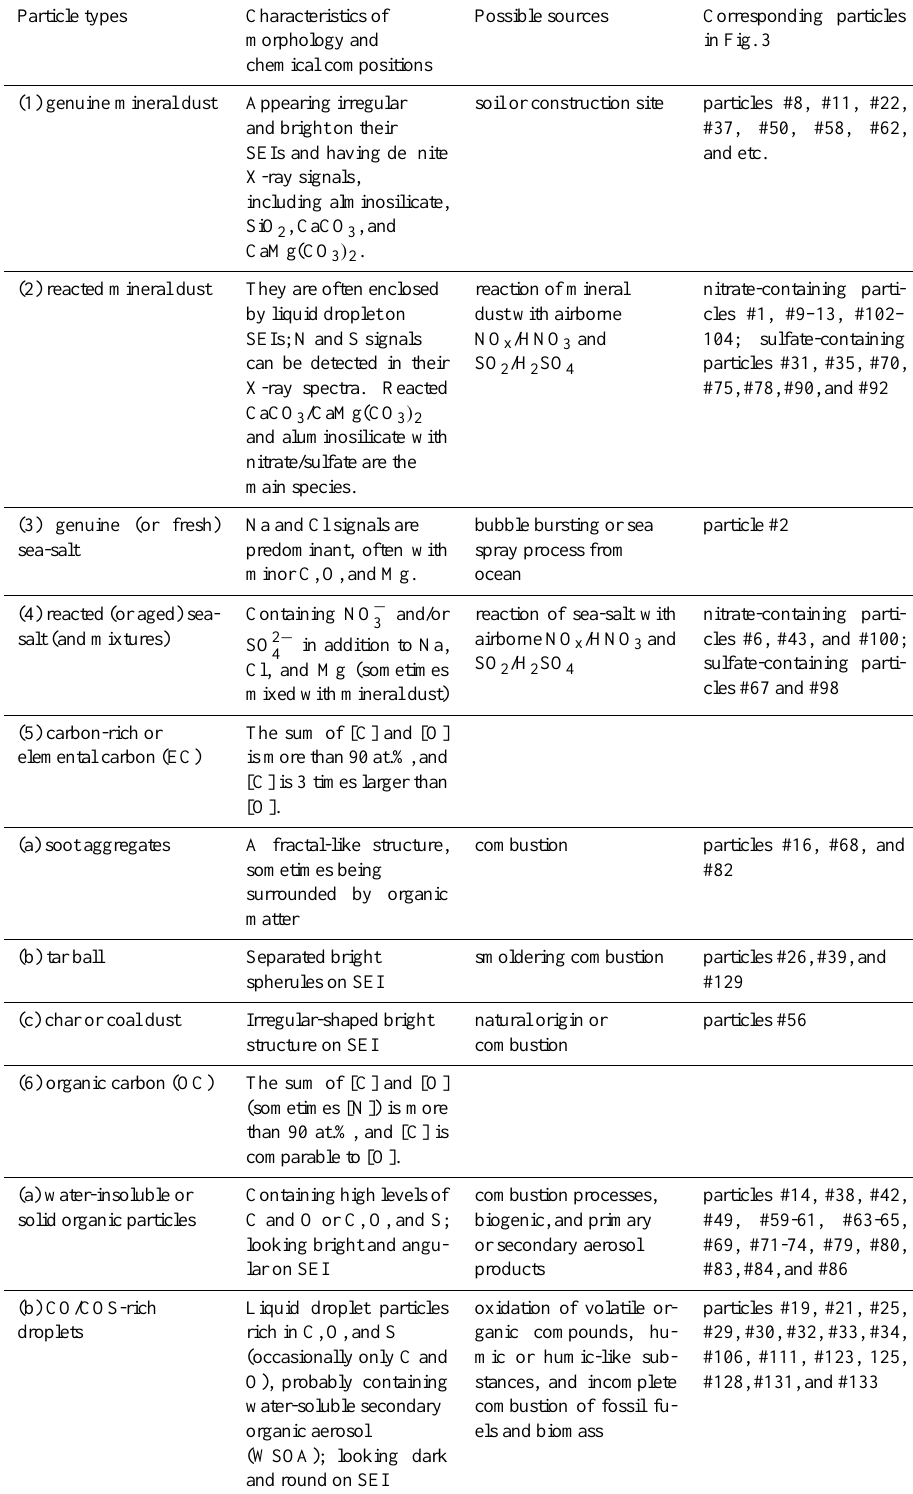
Table 2. Classification of aerosol particles based on SEI and X-ray data. Particle